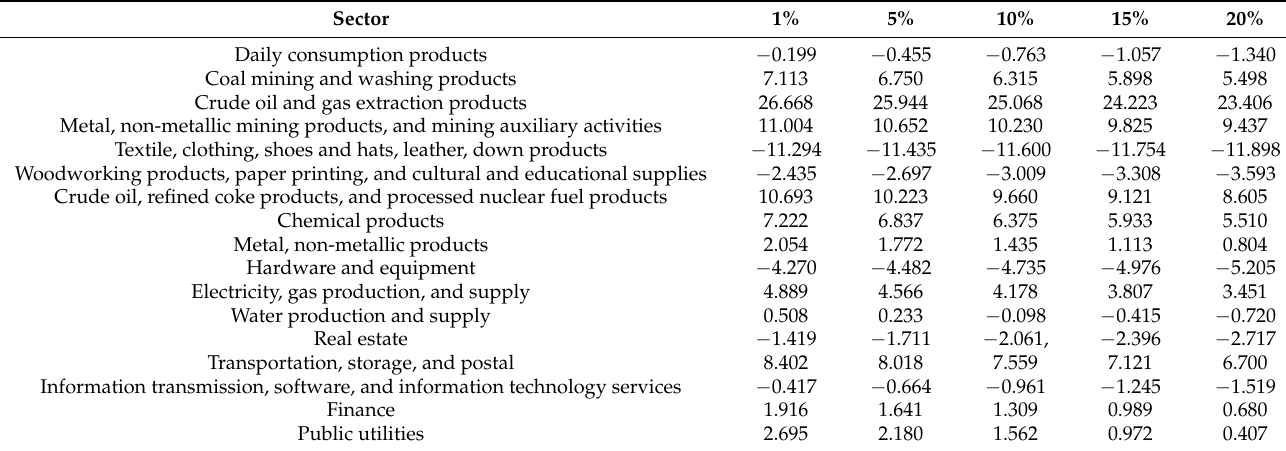
Table A13. The rate of change in output after the rise in crude oil price. Sector